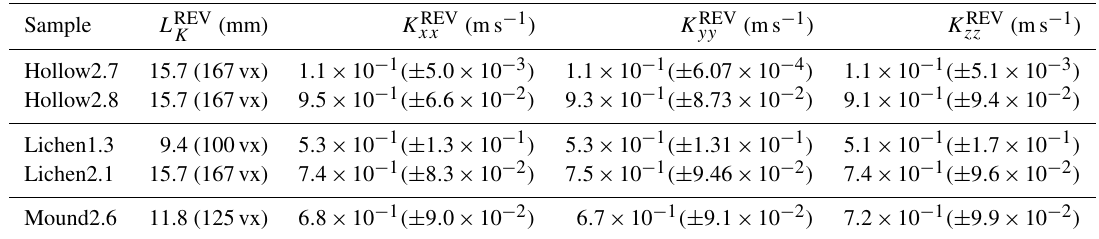
Figure 9. (a) Pressure field (Pa) after a single-phase flow simulation thorough a pore network model based on a Mound2.5 sample. Spherical pore sizes are represented according to their respective size in the network. (b) Pressure field lines (Pa) after a single-phase flow simulation through a sub-sample of the Hollow2.8 sample. The gray mesh corresponds to the isolated biological phase. Table 5. Diagonal components of the hydraulic conductivity tensor (ms − 1 ) for the studied REV K for Type-I samples using direct numerical